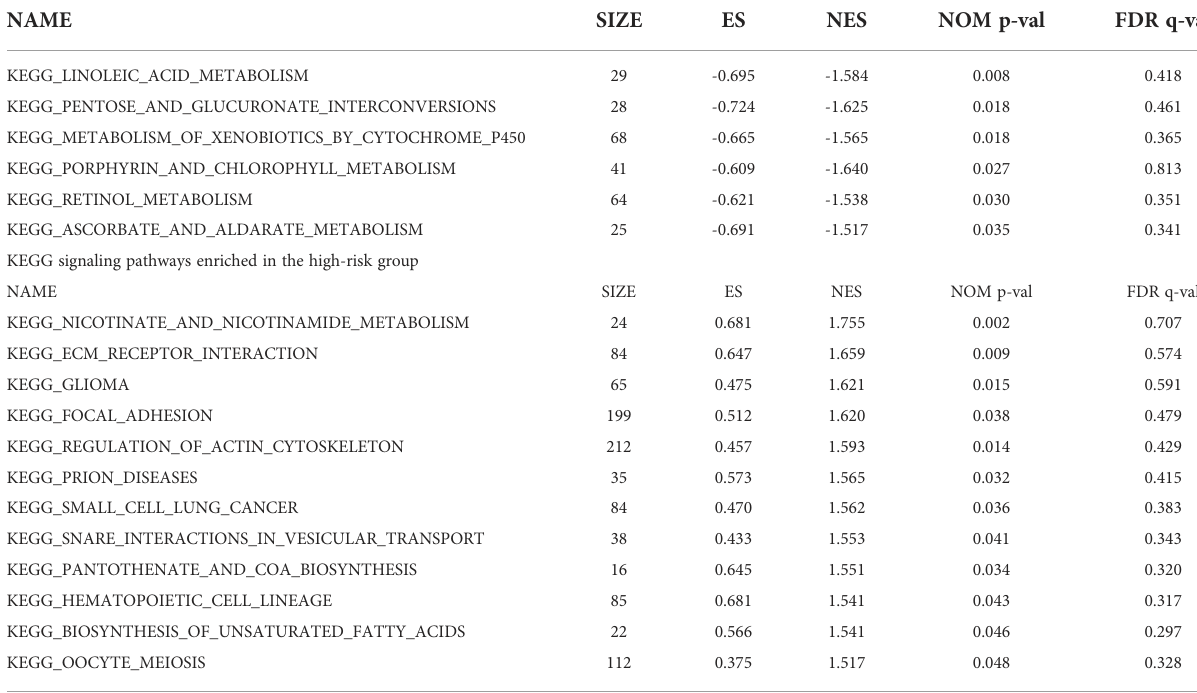
TABLE 2 KEGG signaling pathways enriched in different PPRPS groups. KEGG signaling pathways enriched in the low-risk